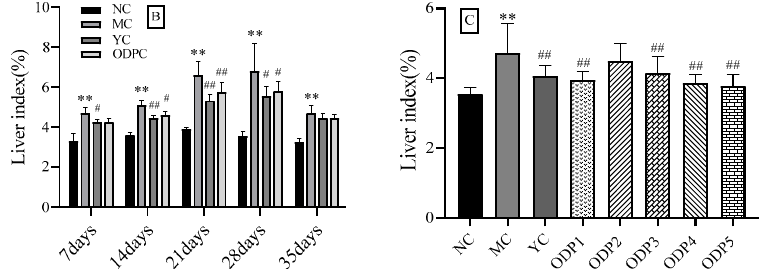
Figure 2. Changes in liver index in different groups of mice: ( A ) effects of cadmium exposure on the liver index of mice; ( B ) time–effect study of ODP; ( C ) dose–effect study of ODP. NC: normal control group, MC: CdCl 2 -treated group, YC: positive-treated group, ODPC: ODP-treated group, ODP1–5: ODP (50, 100, 200, 400, 600 mg/kg)-treated group. The presented values are x ± SD ( n = 6 for each group). * Compared with normal control group (NC group), ** p < 0.01; # compared with model control group (MC group), # p < 0.05, ## p < 0.01.